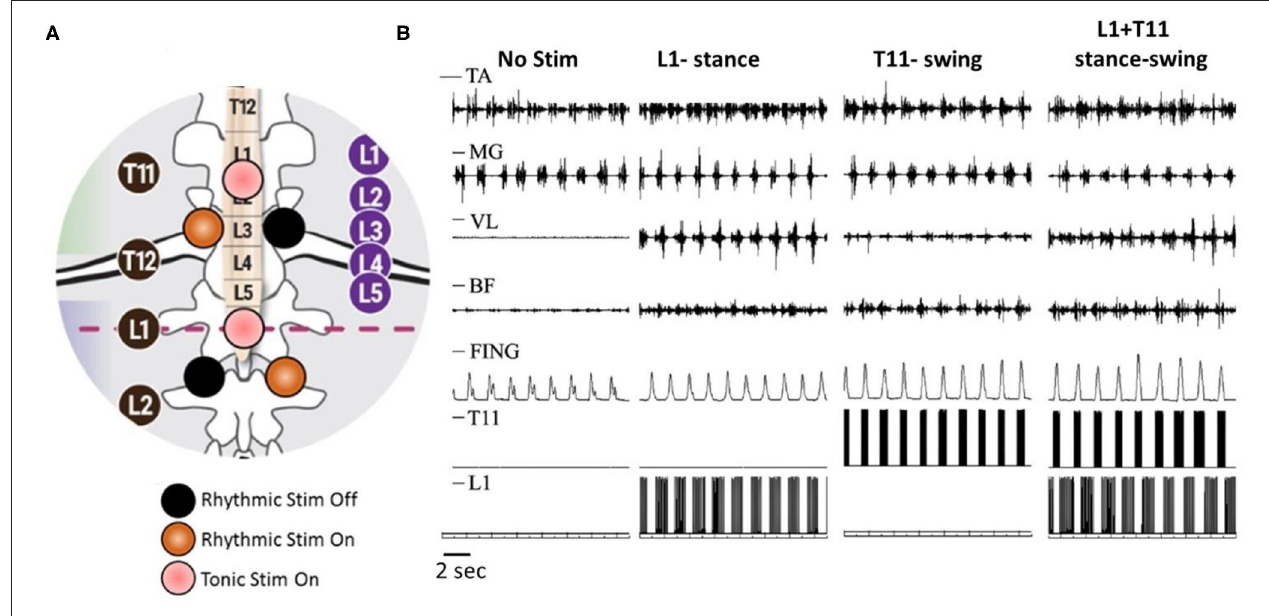
FIGURE 1 | Rhythmic and continues spinal cord transcutaneous stimulation paradigm. (A) Schematic localization of stimulation electrodes. Midline electrodes at T11 and L1 generate continuous stimulation at 30Hz. Lateral electrode at T11 generate rhythmic stimulation at 30Hz during swing phase and lateral electrode at L1 generate rhythmic stimulation at 15Hz during stance phase. (B) Surface EMG activity of distal [tibialis ant. (TA) and medial gastrocnemius (MG)] and proximal [vastus lat. (VL) and biceps femoris (BF)] muscles as well as displacement of terminal poit (Fing) during walking on the treadmill without stimulation, with rhythmic stimulation of L1 at stance phase, with rhythmic stimulation of T11 at swing phase, and combined L1 and T11 stimulation applied to stance and swing phase,